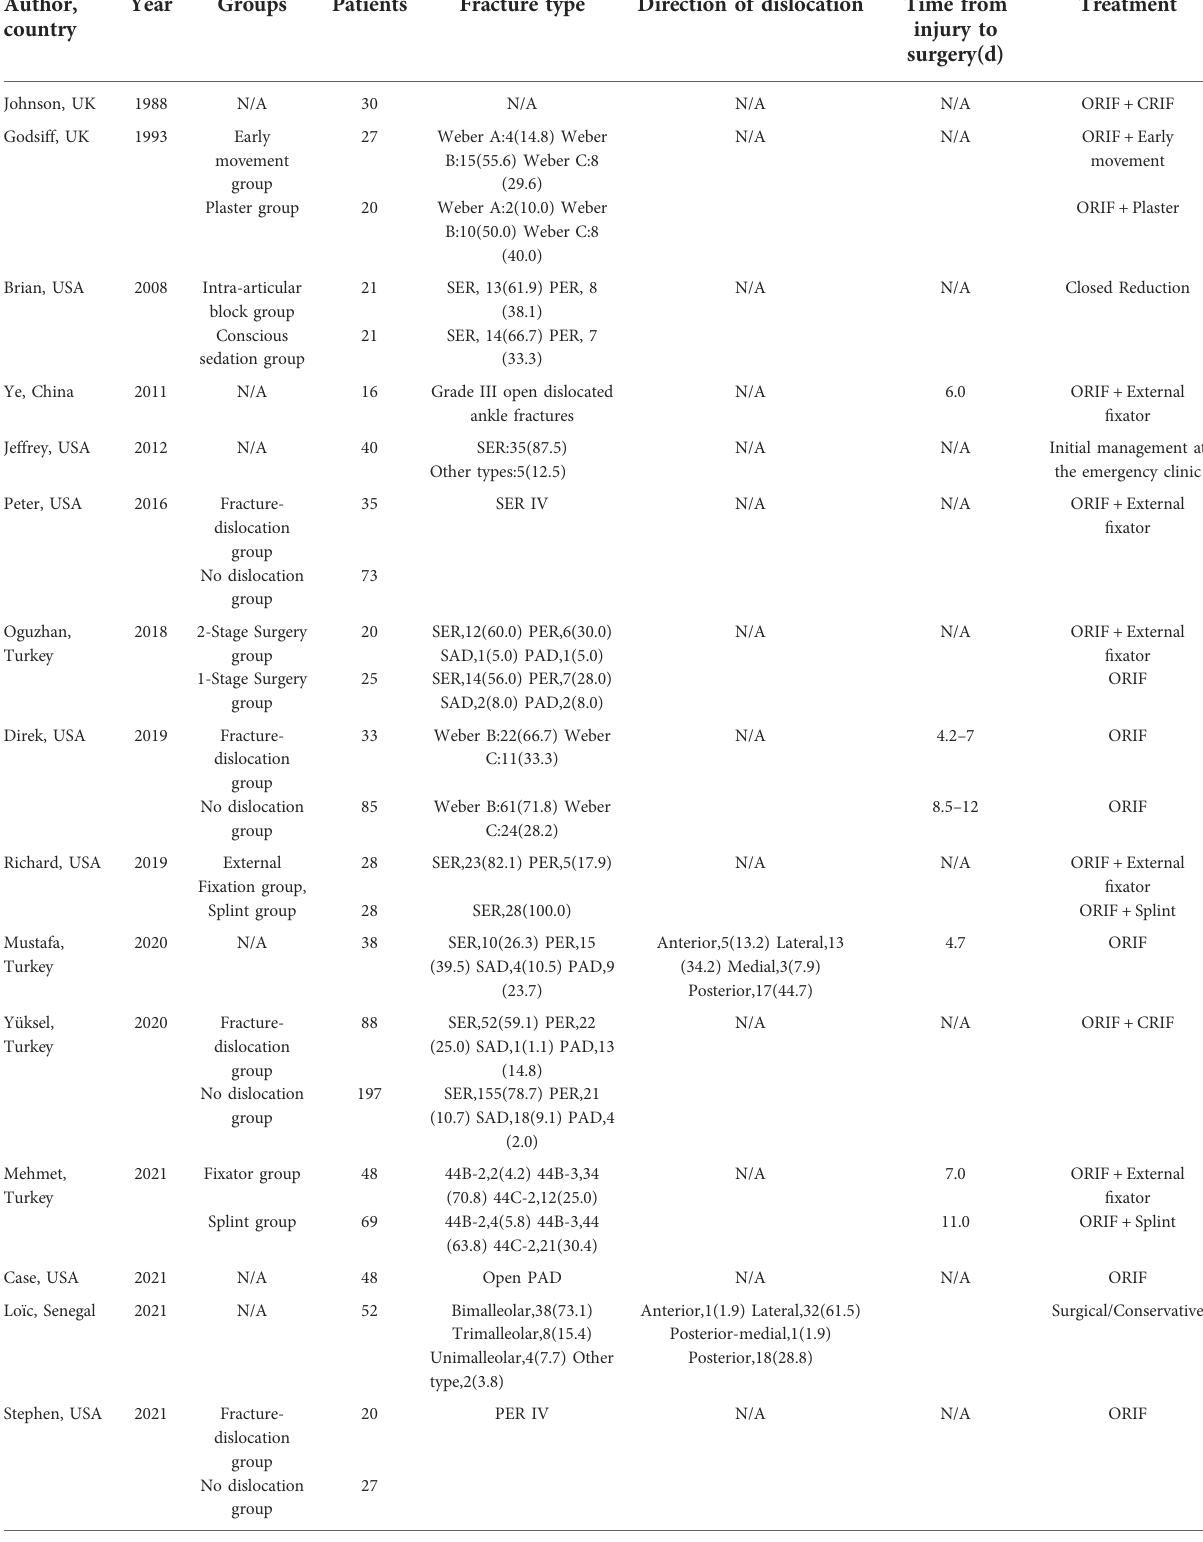
TABLE 3 Clinical characteristics of the 15 included